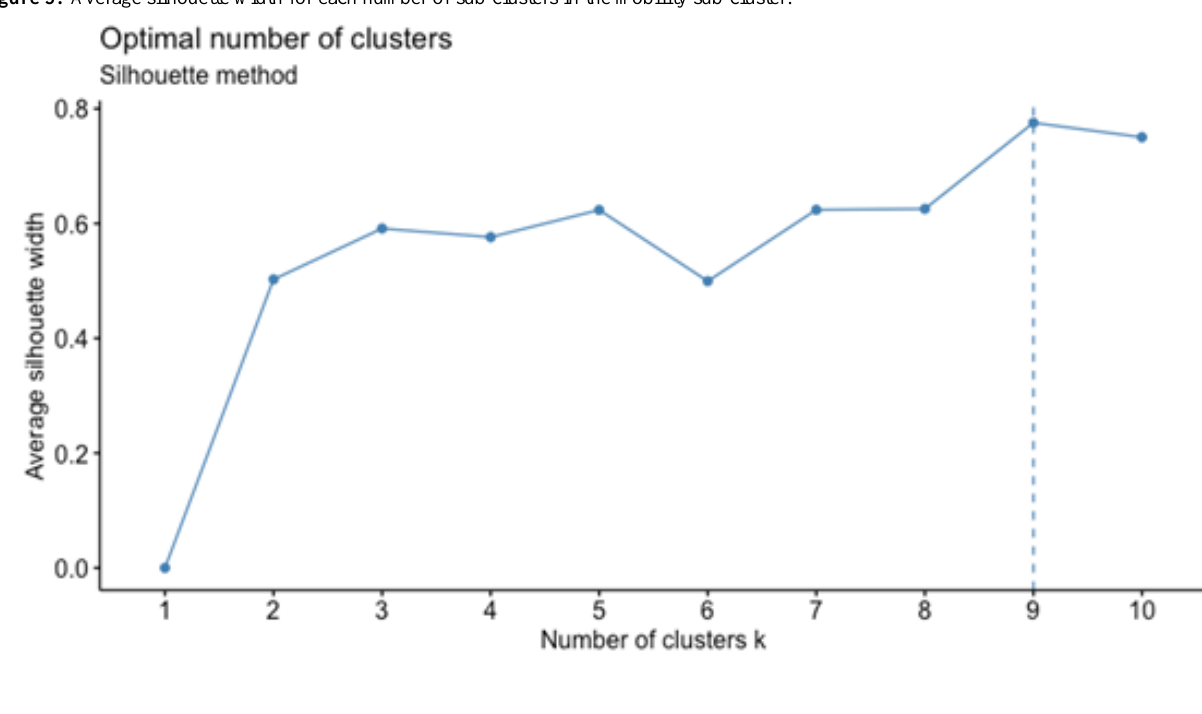
Figure 5. Average silhouette width for each number of sub-clusters in the mobility sub-cluster.